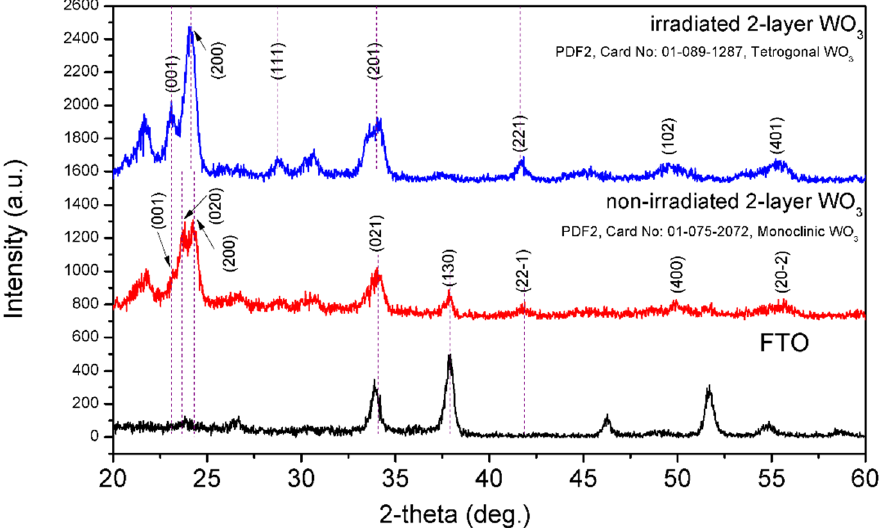
Figure 3. GI-XRD patterns of irradiated and non-irradiated double-layer WO 3 thin films. Bottom plot shows GI-XRD pattern of the FTO substrate.